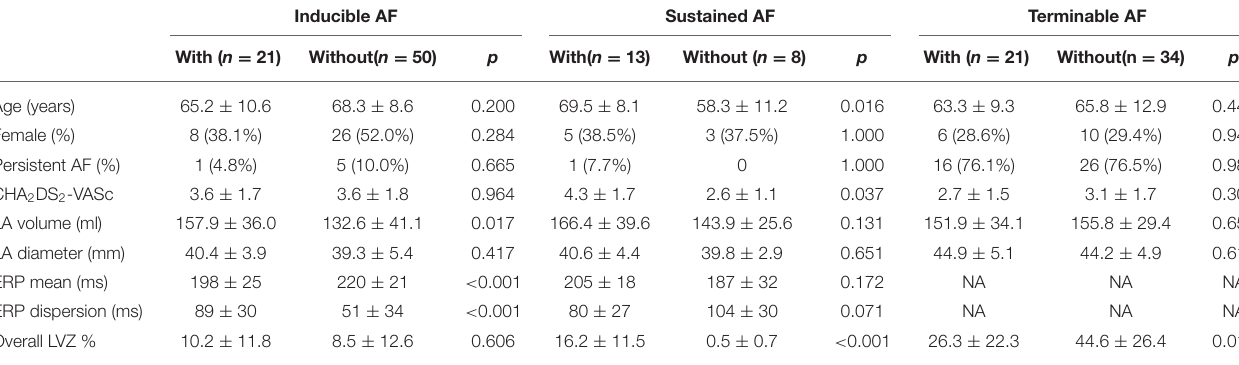
TABLE 2 | Comparison between patients with and without inducible, sustained, and terminable atrial fibrillation (AF).